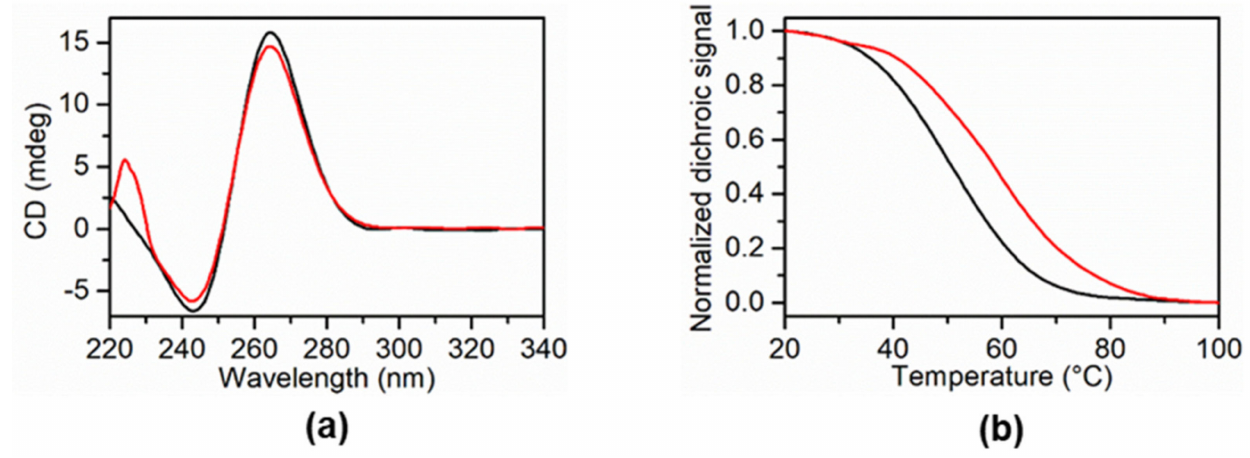
Figure 6. ( a ) Circular Dichroism (CD) spectra of KRAS 22RT in the absence (black line) and in the presence (red line) of 5a . ( b ) CD melting curves of KRAS 22RT in the absence (black line) and in the presence (red line) of 5a